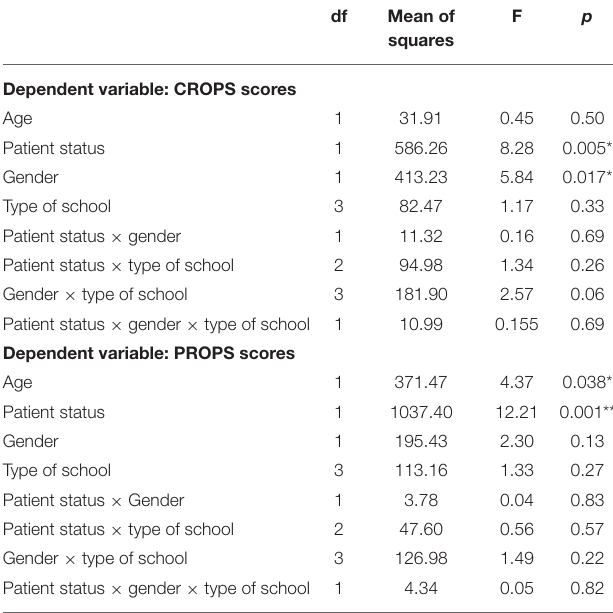
TABLE 2 | ANCOVA with CROPS/PROPS total scores as dependent and age, patient status, gender, and type of school as independent variables. df Mean of